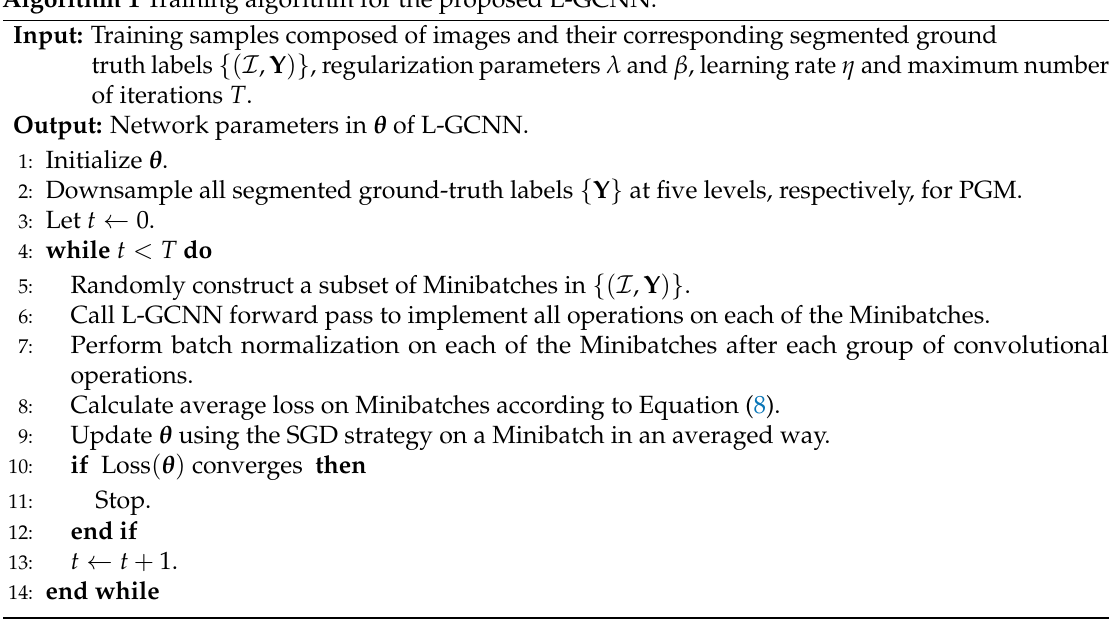
Algorithm 1 Training algorithm for the proposed